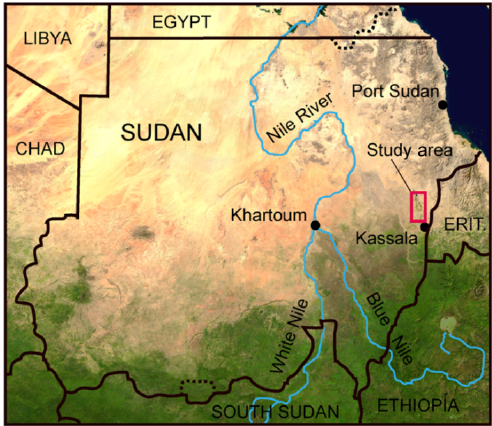
Figure 1. Location of the study area (source of satellite image: http: //www.maplibrary.org/).